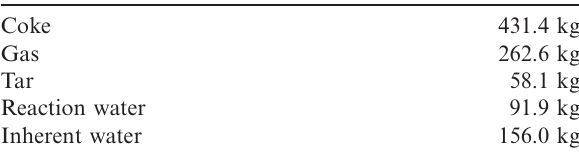
Table 1. Mass balance of coking brown coal